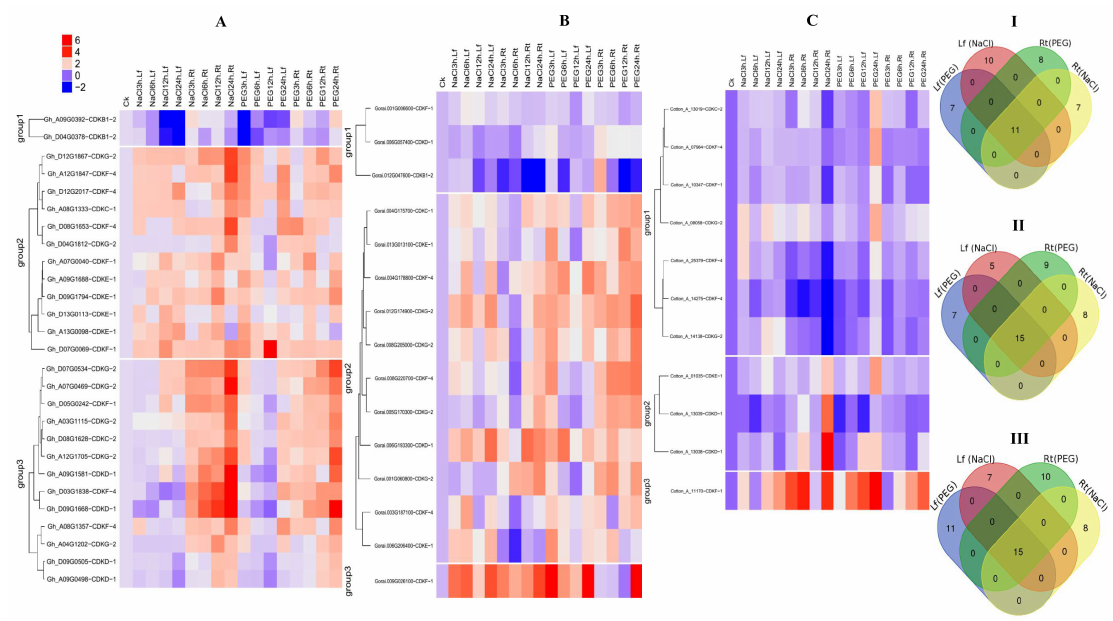
Figure 5. Transcriptome profiling of CDK gene expression through RT-qPCR under salt and drought stress. ( A – C ) Heat map displaying expression changes of differentially expressed CDK genes in G. hirsutum , G. raimondii , and G. arboreum respectively plants stressed for 3 h, 6 h, 12 h and 24 h of salt and drought stress compared with the control; (I, II and III) Venn diagram depicting the number of up regulated CDK genes in root and leaf tissues at 24 h of drought (PEG) and salt (NaCl) stress exposure. 2.9. RT-qPCR Validation of the Highly Upregulated CDK Genes in Tisues of G. tomentosum (Tolerant)